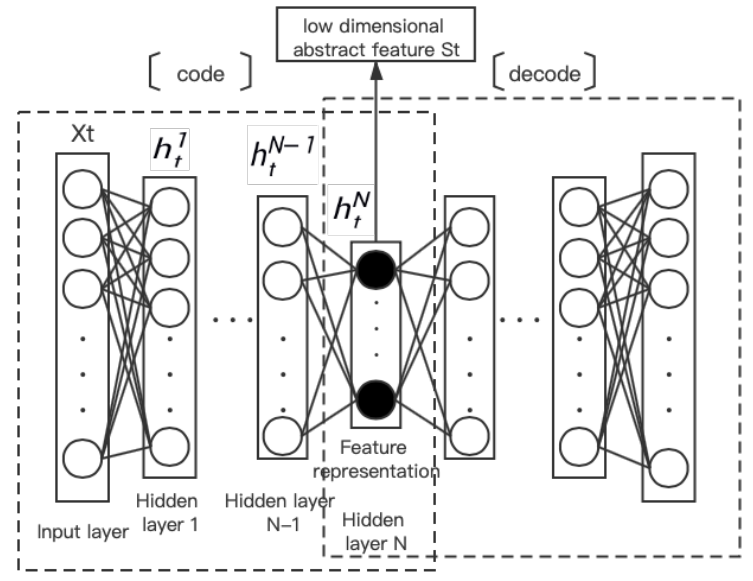
Figure 1. The network structure of